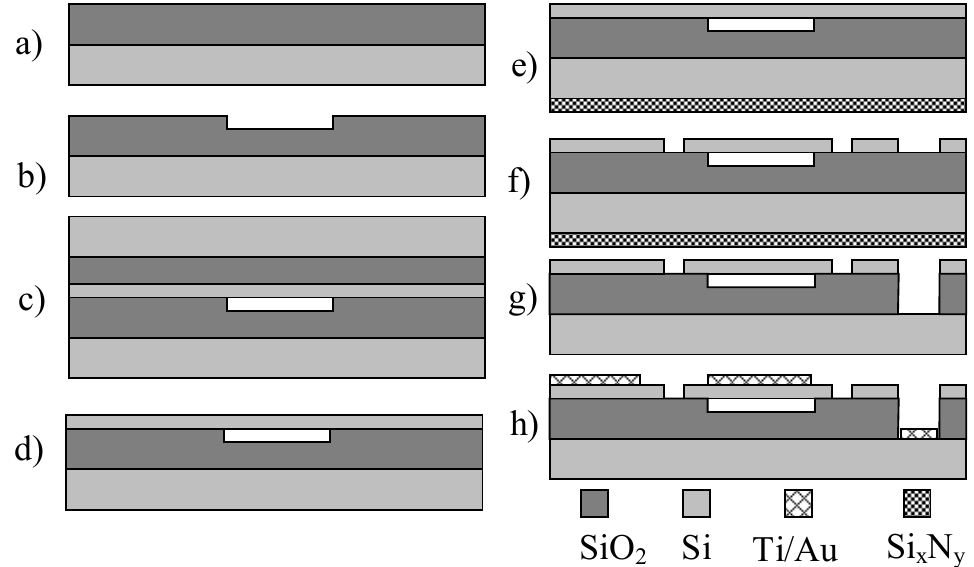
Figure 5. Wafer bonding CMUT device fabrication steps: ( a ) thermal oxidation, ( b ) cavity formation, ( c ) wafer bonding, ( d ) handle and buried oxide removal, ( e ) backside protection layer, ( f ) device and membrane separation, DRIE (Deep Reactive Ion Etch) or Oxford, ( g ) contact formation, and ( h ) metallization, electrode